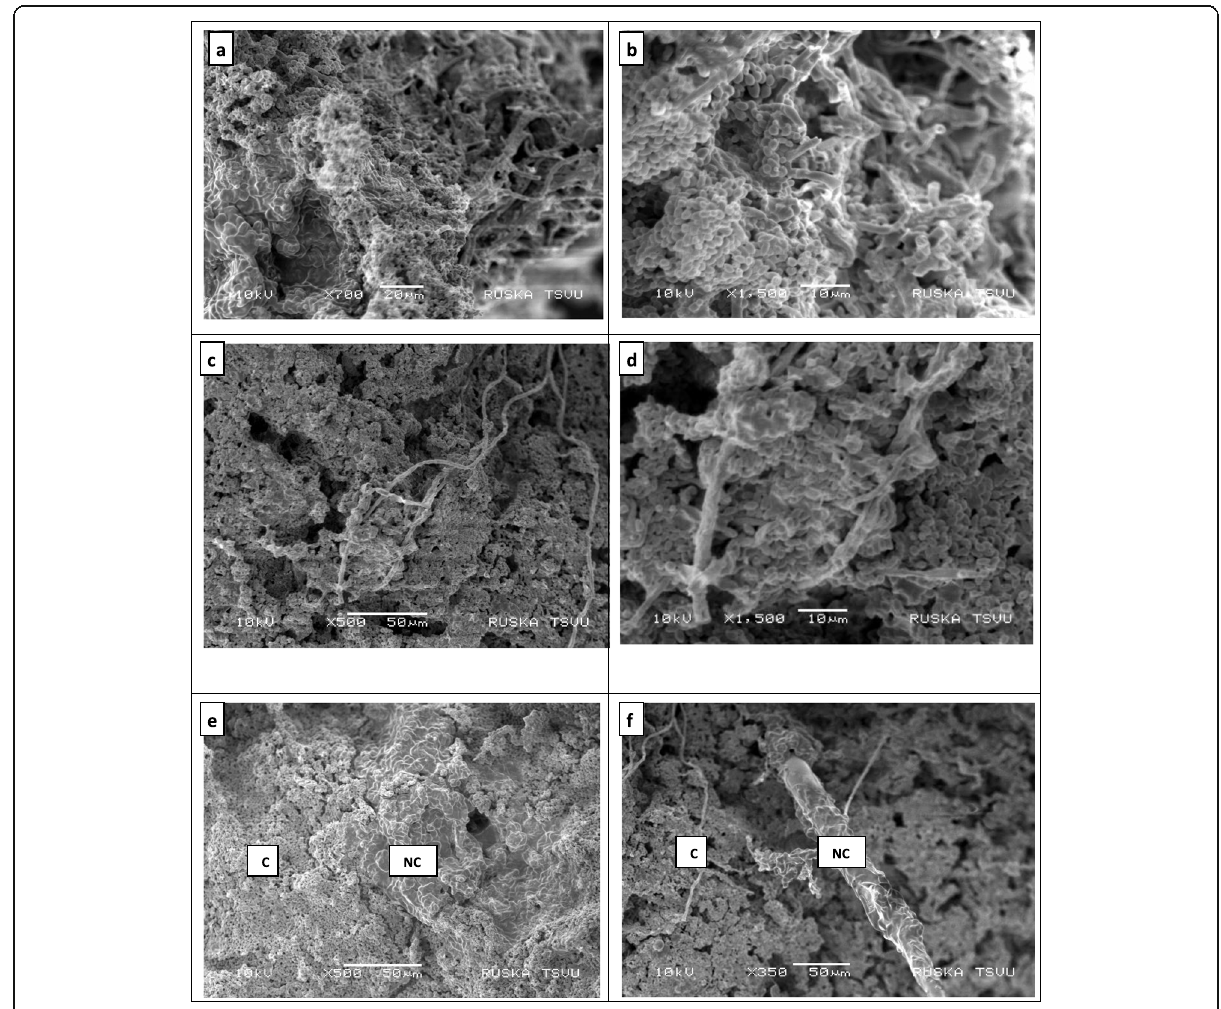
Fig. 8 Scanning electron microscopy of Metarhizium rileyi mycosis on larval instars of Spodoptera frugiperda . a , b Mycelium and conidia of M . rileyi on integument of S . frugiperda . c , d Hyphal penetration into the integument of S . frugiperda . e , f Non-colonization of M . rileyi on thoracic shield and